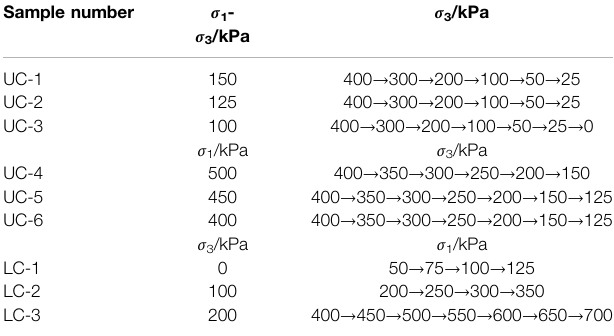
TABLE 2 | Loading and unloading programs.